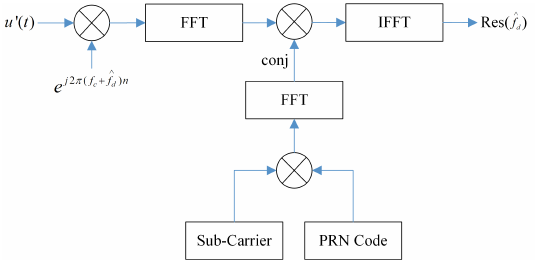
Figure 4. Coarse acquisition procedure for FH-BOC